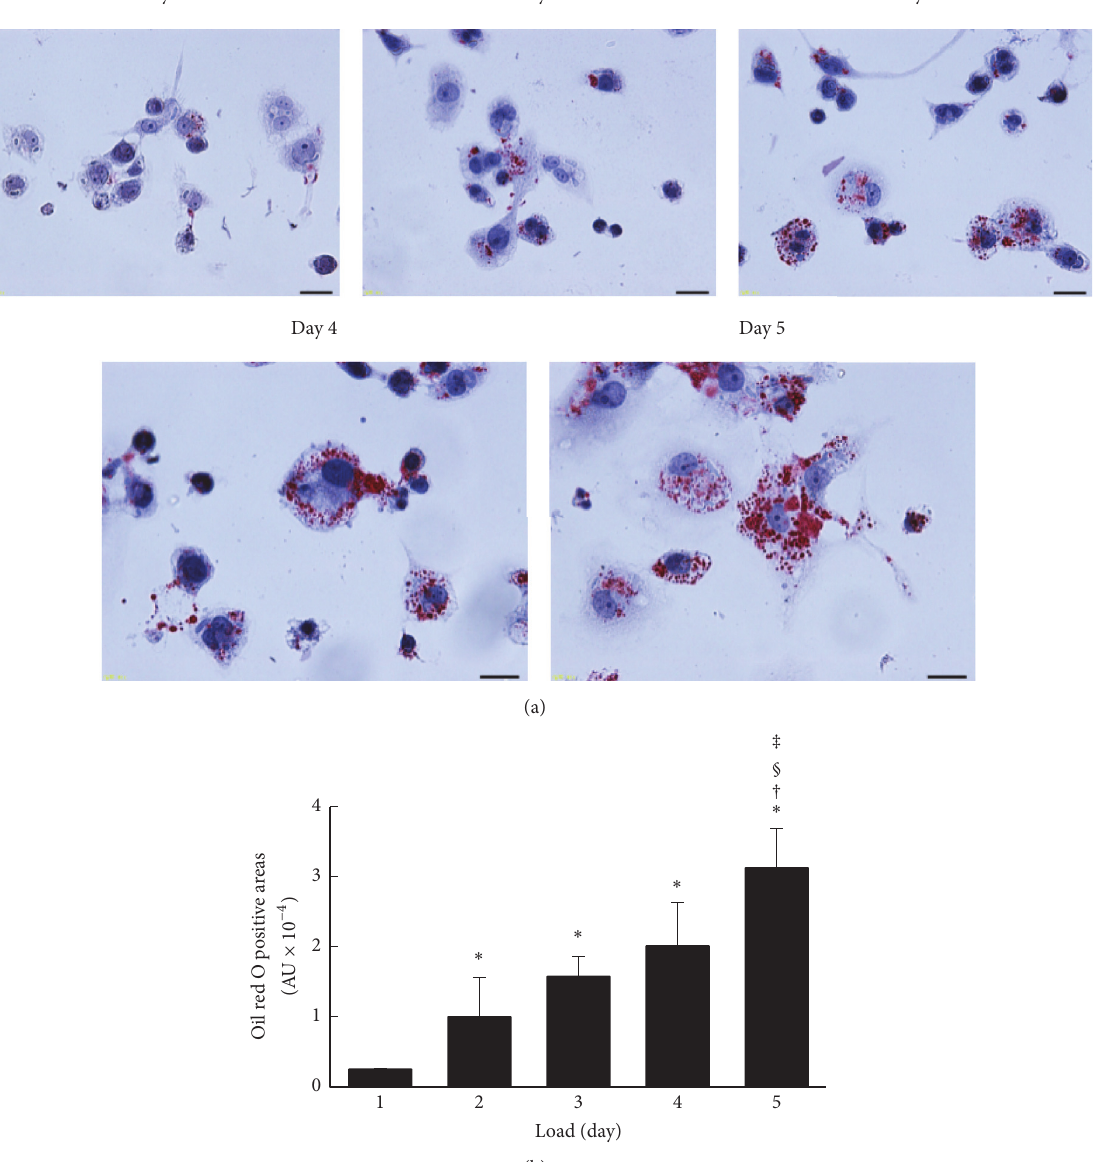
Figure 4: Foam cell formation. (a) After PMA treatment for 2 days, cells were loaded with acLDL (50 𝜇 gprotein/mL) and T0901317 (1 𝜇 mol/L) for indicated periods. After equilibration, cells were stained with oil red O and hematoxylin (scale bars, 20 𝜇 m). (b) Semiquantitative analysis of oil red O positive cells was performed using the ImageJ (National Institutes of Health). The values were indicated by mean + SD ( 𝑛 = 3, ∗ 𝑃 < 0.05 versus day 1, † 𝑃 < 0.05 versus day 2, § 𝑃 < 0.05 versus day 3, and ‡ 𝑃 < 0.05 versus day